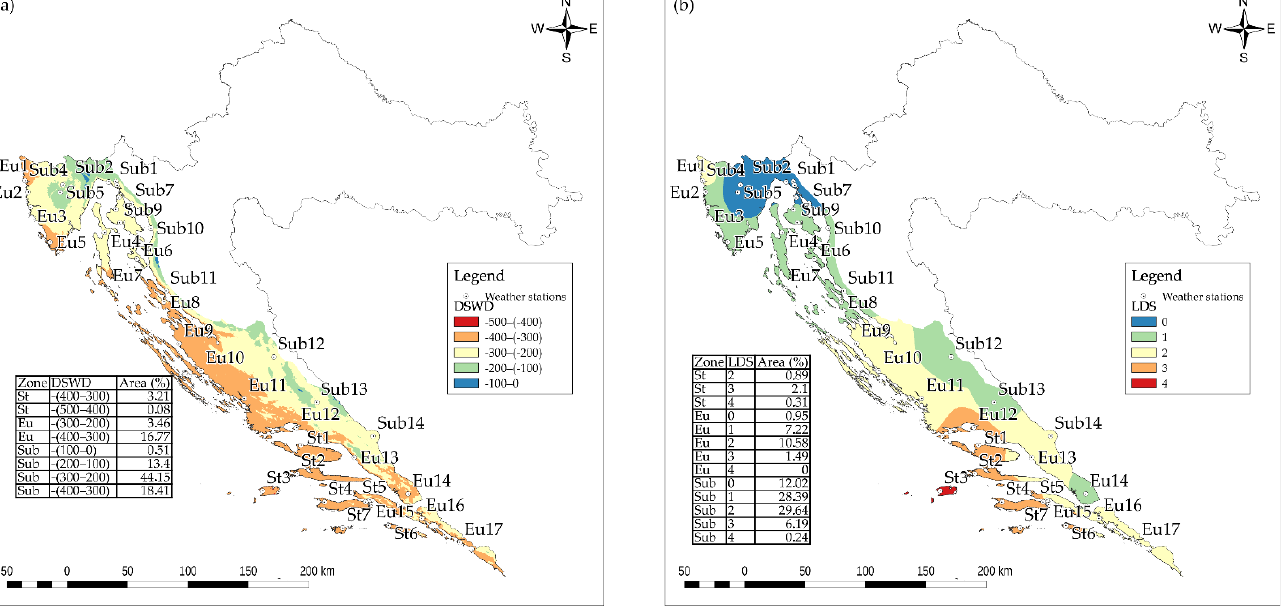
Figure 5. ( a ) Dry season water deficit (DSWD), ( b ) Length of the dry season (LDS).